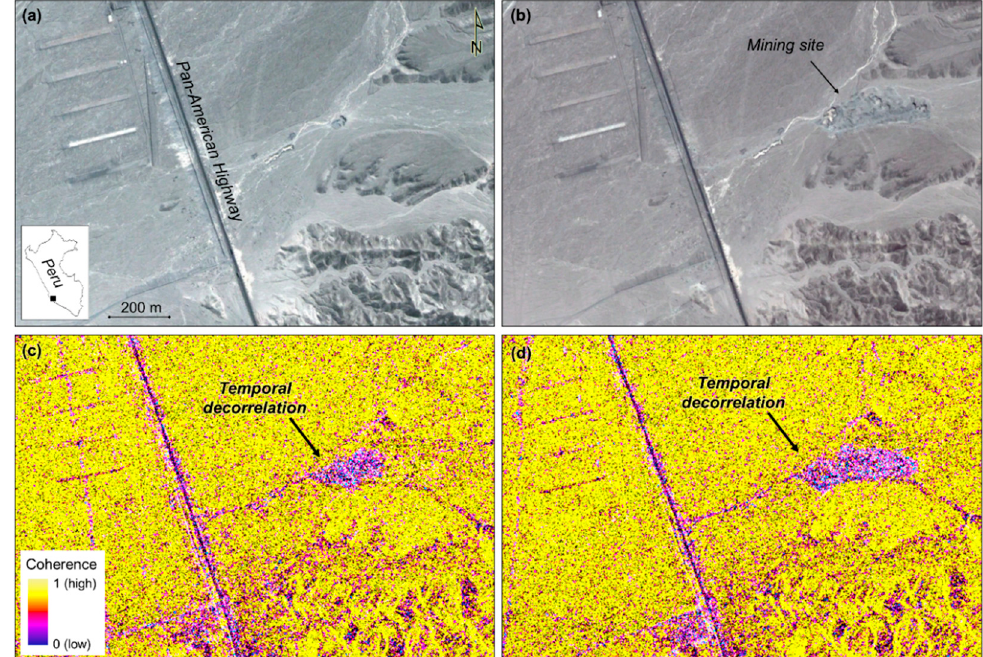
Figure 9. ( a ) The 2013 vs. ( b ) the 2016 satellite view of a desert area near Palpa (Peru), where a mining site was developed east of the Pan-American Highway (Google Earth images © 2018 DigitalGlobe); and InSAR coherence from two pairs of COSMO-SkyMed StripMap Himage mode (~3 m ground resolution) pairs: ( c ) 31 / 07 / 2013–16 / 06 / 2014 (5 m perpendicular baseline) and ( d ) 10 / 07 / 2014–05 / 07 / 2015 (30 m perpendicular baseline). COSMO-SkyMed ® Products © ASI—Italian Space Agency—2013–2015. All Rights Reserved.